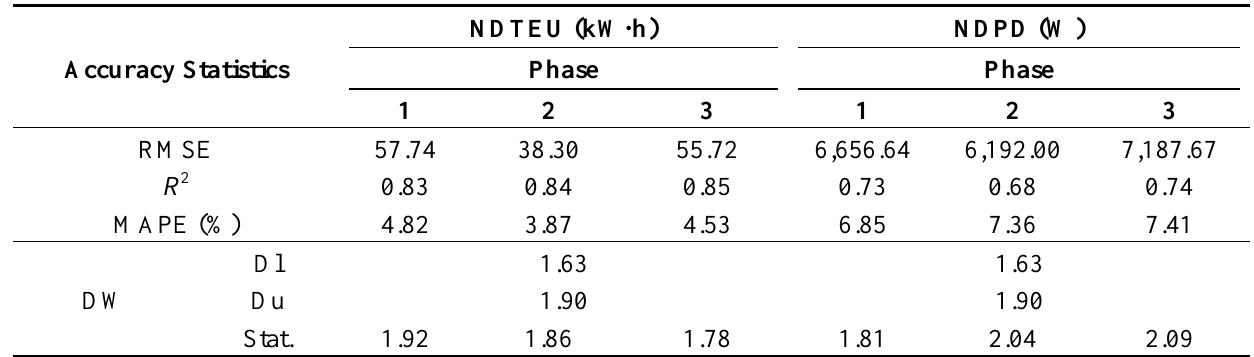
Table 4. NN hindcast